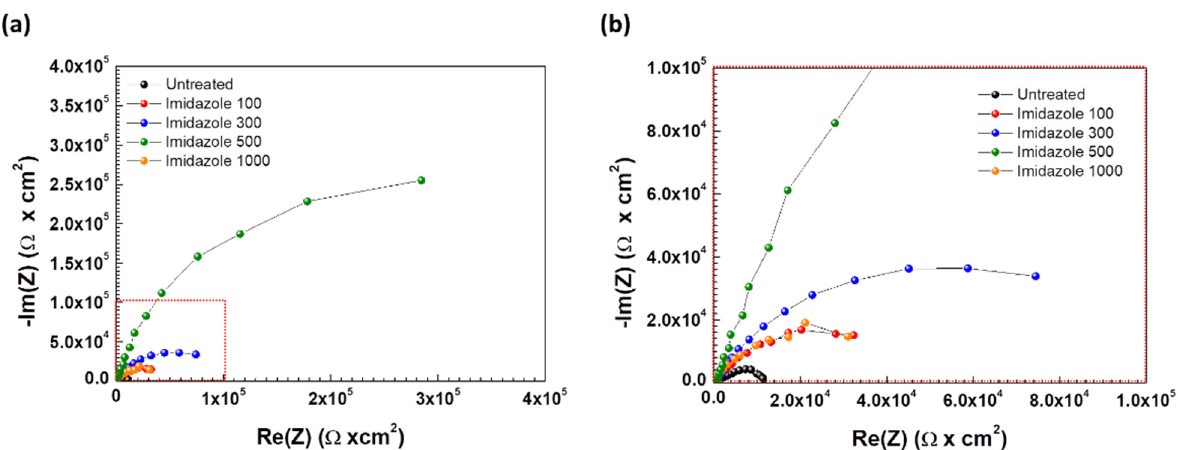
Figure 3. ( a ) Nyquist plots for SPPS-38 carbon steel weldment as a function of imidazole concentration in the deaerated district heating water at 60 °C and ( b ) enlarged image of red dotted square area.